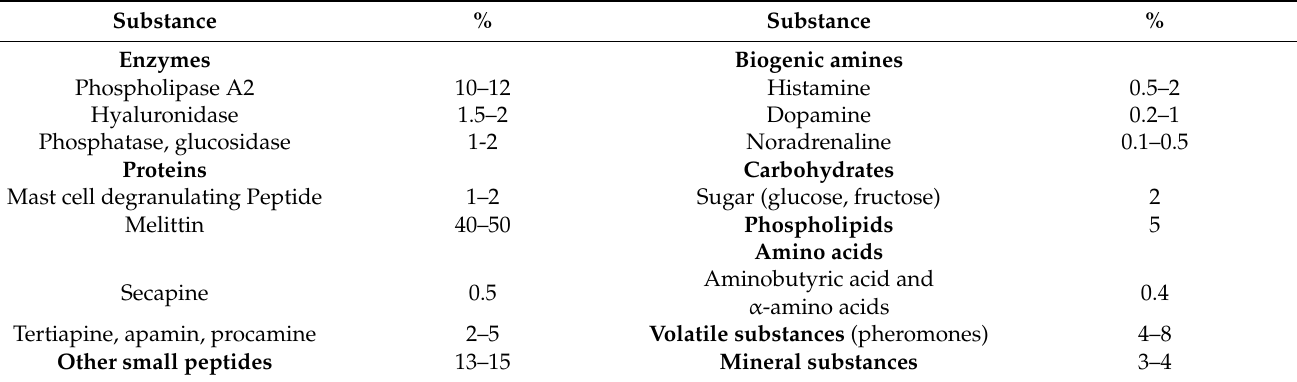
Table 1. Composition of bee venom: dry matter data according to Dotimas and Hider (1987)